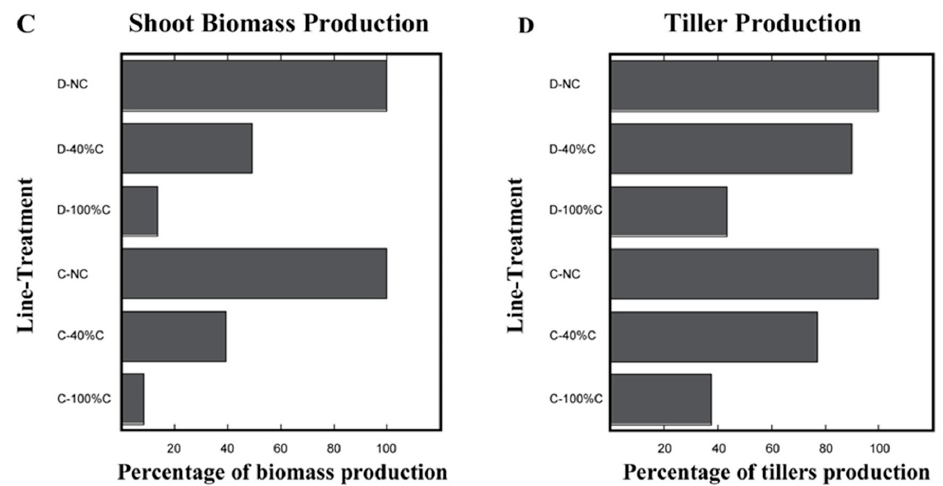
Figure 4. Aboveground biomass re-growth in two wheat cultivars subjected to defoliation. ( A ) Shoot biomass. ( B ) Number of tillers. ( C ) Percentage of shoot biomass recovery in Duster and Cheyenne after leaf clipping, compared to non-clipped plants (represented as 100% of shoot biomass production). ( D ) Percentage of tiller recovery in Duster and Cheyenne after leaf clipping, compared to non-clipped plants (represented as 100% of tiller production). No leaves clipped = NC, 40% of the leaves clipped = 40% C, and 100% of the leaves clipped = 100% C. Duster = D and Cheyenne = C. Error bars represent standard deviation of the mean. N ≥ 13 ten-week-old plants. Statistically significant differences of the means were determined using one-way ANOVA and Tukey’s tests. Different letters represent distinct means within groups at p < 0.05.